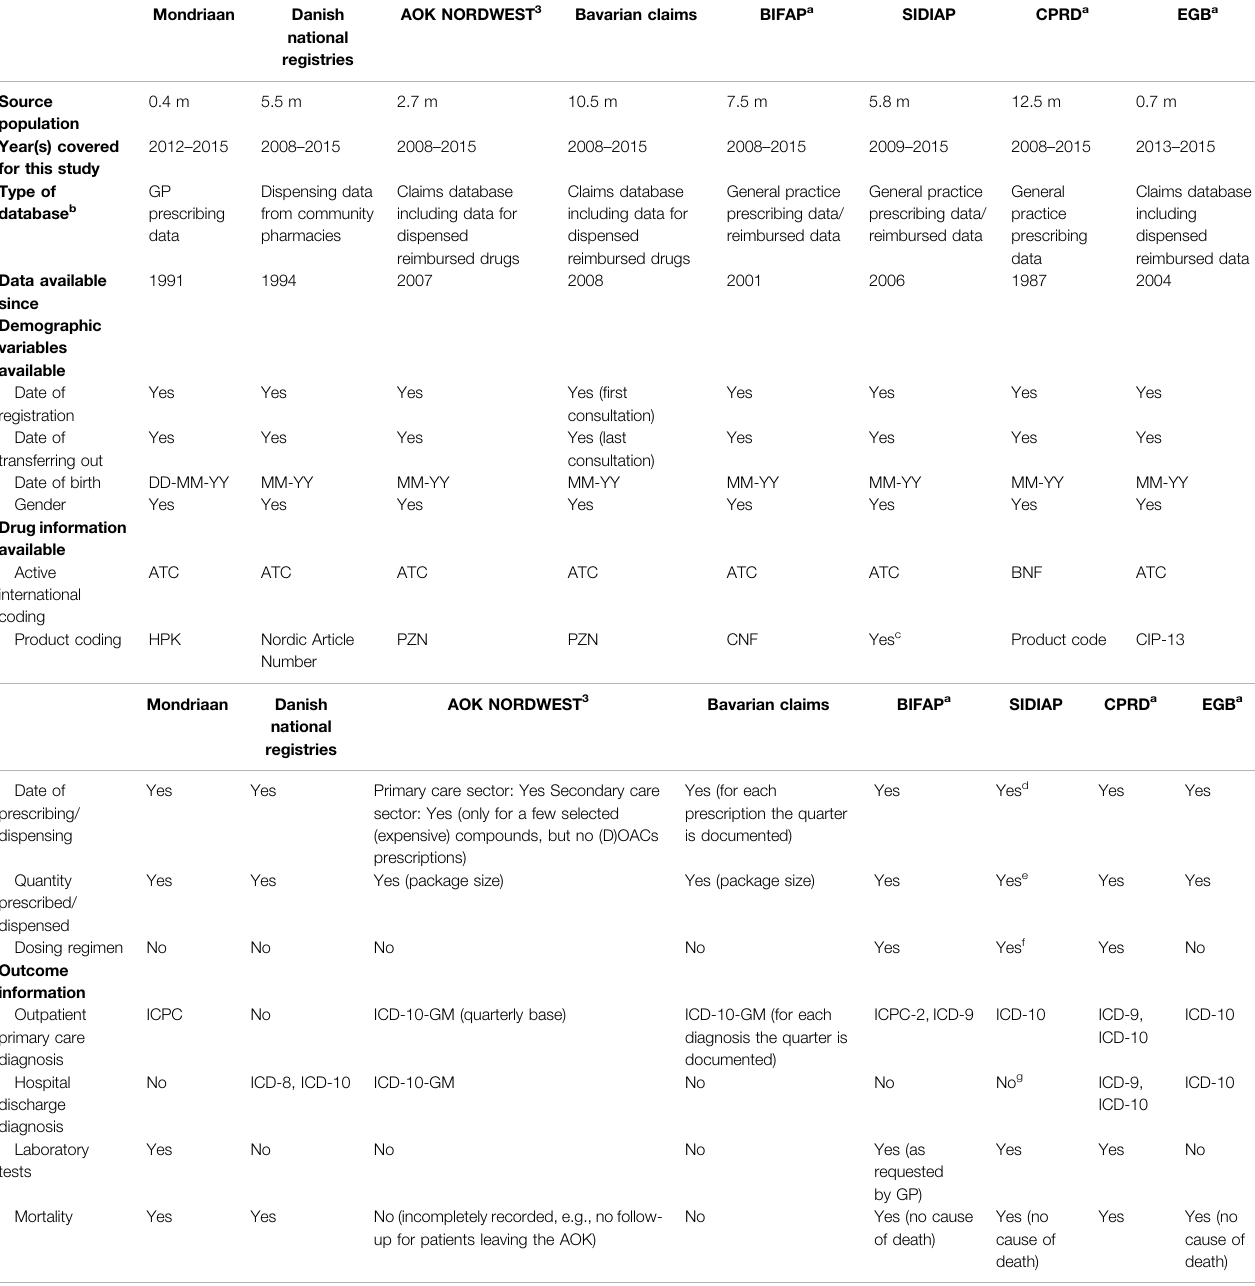
TABLE 1 | Database